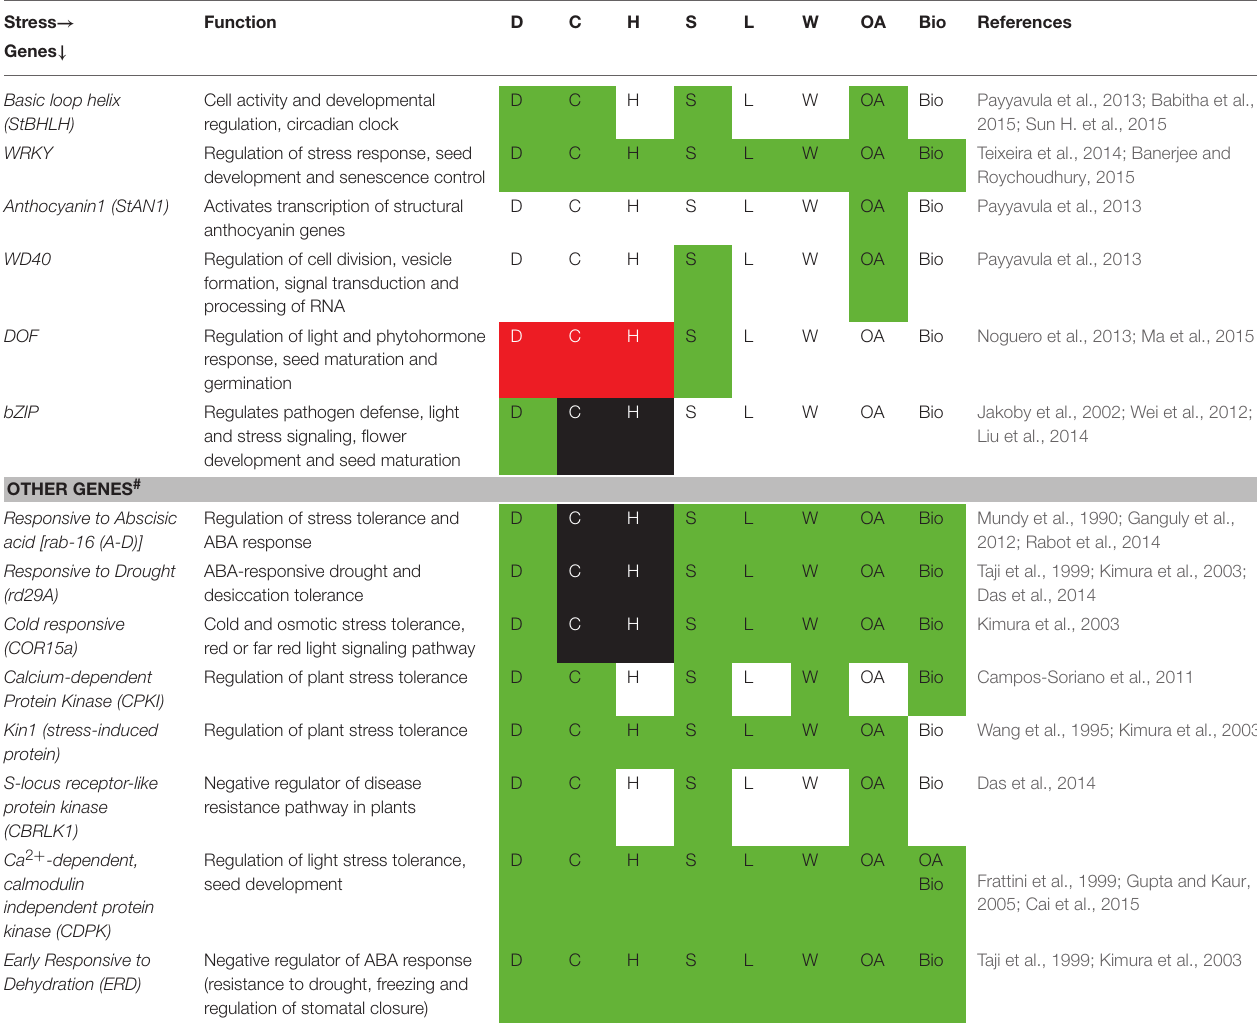
# classification of genes into primary, specialized and TF clusters is based on literature evidence, KEGG map01100 and their function. D, drought; C, cold; H, heat; S, salinity; Bio, biotic stress; L, light; W, wounding; OA, other abiotic (like elicitors: ABA, jasmonic acid, salicylic acid, ethylene; exogenous chemical treatment like glucose/sucrose supplementation etc.); green box, upregulation; red box, downregulation; black box, differential/inconsistent expression; white box, information